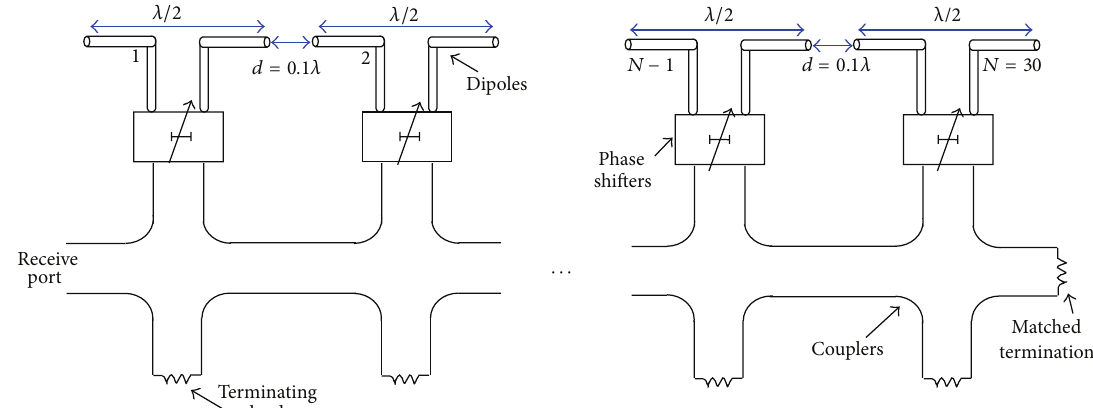
Figure 8: Schematic for 30-element series-fed dipole array.